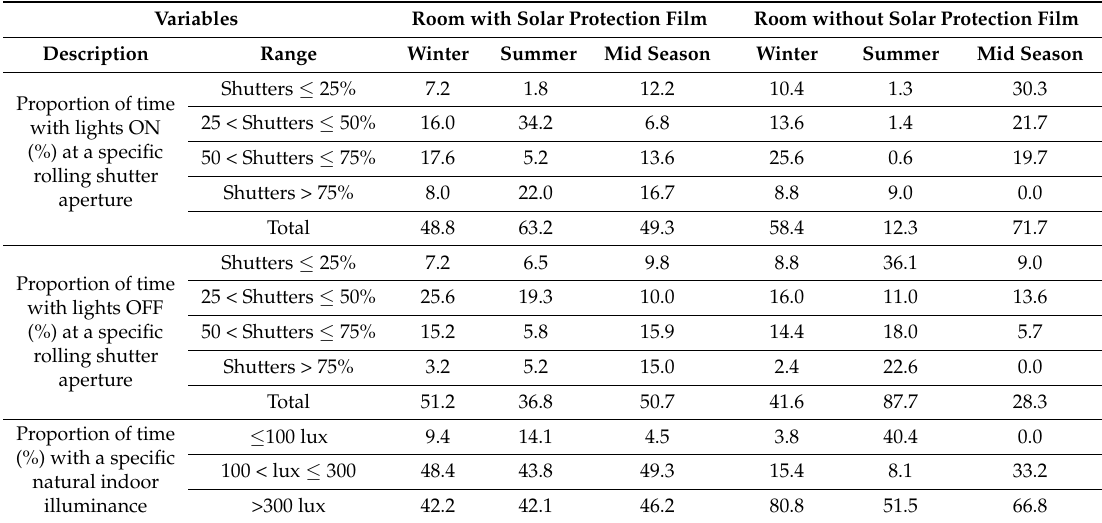
Table 5. Results of the descriptive statistical analysis. Source: